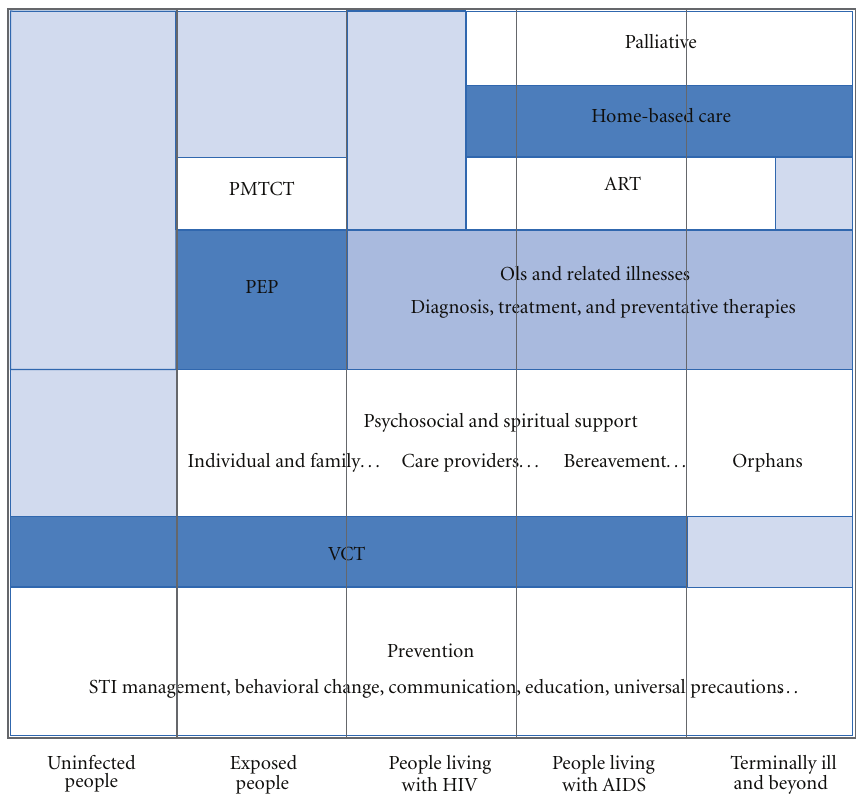
Figure 1: Continuum for a comprehensive response to